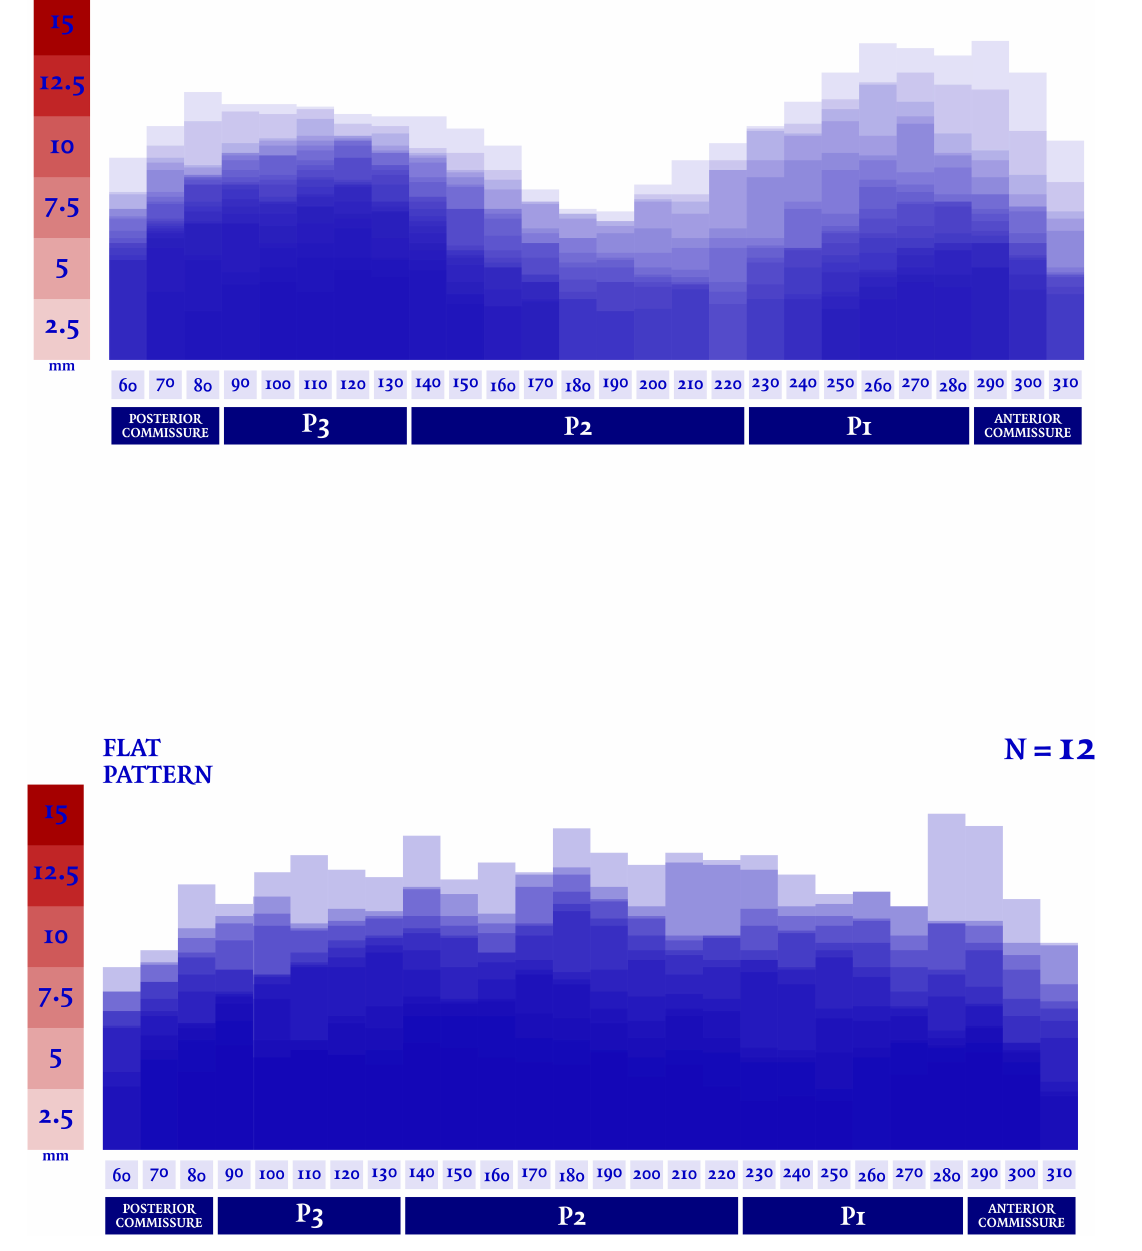
FIGURE2 Disjunction distance (DD) was measured in multiple planes orthogonal to the ideal annular plane, rotating at 10 ◦ intervals. Each value was singularly plotted into a distribution map and then two patterns of disjunction were identified. A commissural pattern was recognized in 21 patients, conversely a flat pattern of disjunction was observed in 12